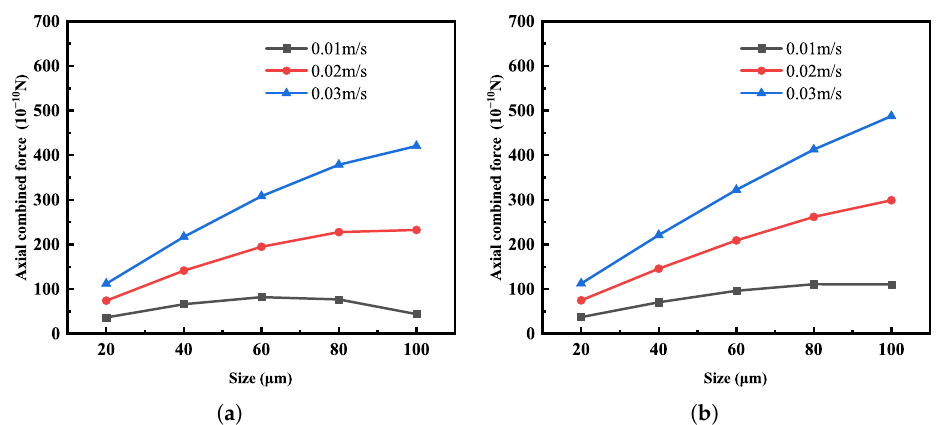
Figure 12. The relationship between the axial combined force on different types of particles and the particle size and axial water flow rate. ( a ) Ilmenite, ( b ) Gangue